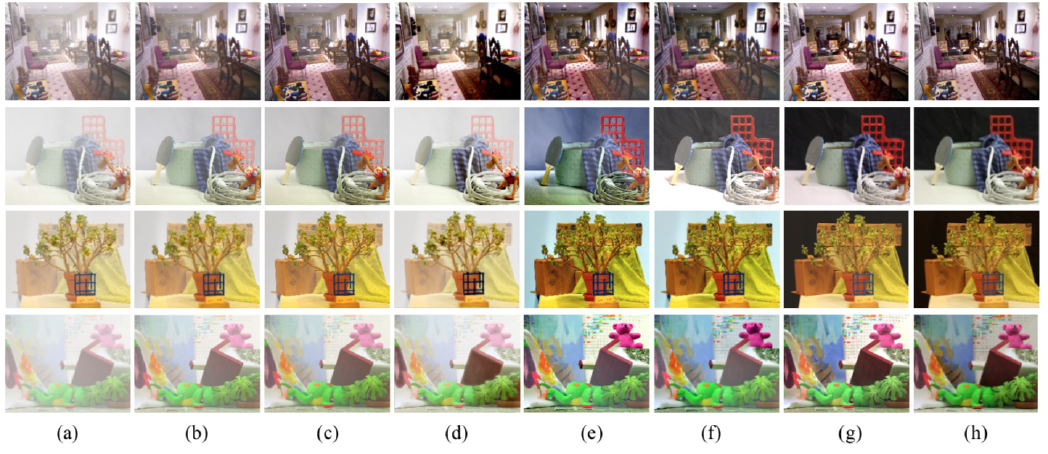
Figure 13. Samples of visual comparison of proposed system’s results with the comparative methods on synthetic indoor hazy images: ( a ) hazy image; ( b ) He’s method [14]; ( c ) Cai’s method [28]; ( d ) Ren’s method [26]; ( e ) Li’s method [40]; ( f ) Salazar’s method [35]; ( g ) our method; and ( h ) ground truth.